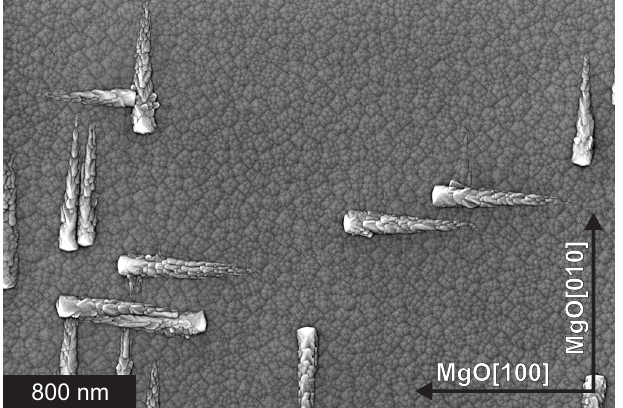
Figure 6. SEM picture of a Fe parallel to MgO (cid:104) 100 (cid:105) . On the surface, pyramidal features parallel to MgO (cid:104) 100 (cid:105) are visible.